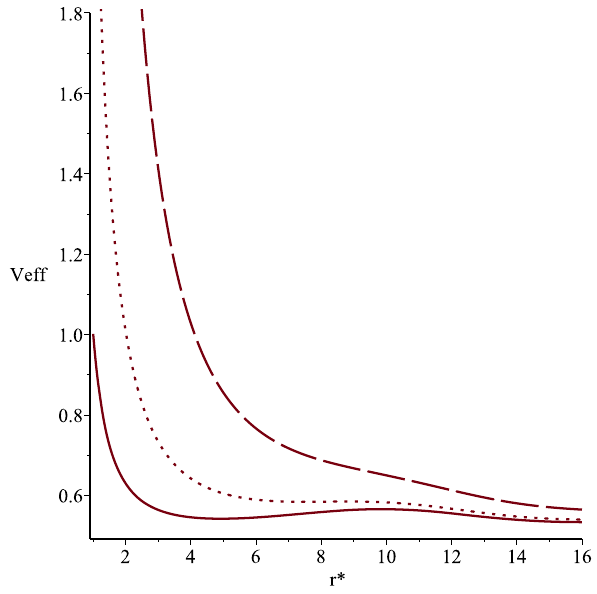
Fig. 15 Plot of the effective potential (49) for = 1, ξ = 0.2, H = 10 with L = 1 (solid line), L = 2 (dotted line) and L = 5 (long dashed line)